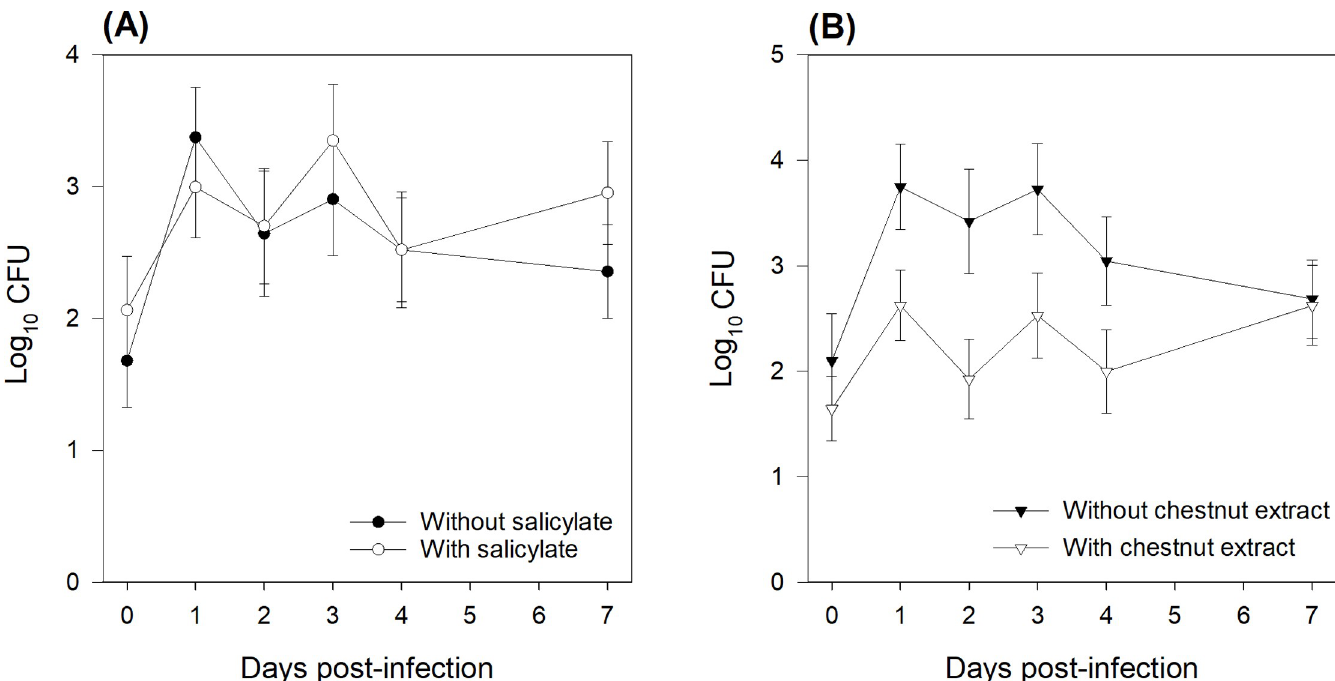
Fig 3. Effects of sodium salicylate supply (A) and chestnut extract supplementation (B) on Enterotoxigenic Escherichia coli F4 shedding as determined using plate counting in feces samples collected from all piglets at days 0, 1, 2, 3, 4 and 7 post-infection. Data are expressed as log 10 (Colony Formant Units). From days 0–4, pigs (N = 36) in the SA+ group were offered a daily dose of sodium salicylate (35 mg/kg BW per day, sodium salicylate, ReagentPlus 1 , S3007, Sigma-Aldrich Chemie GmbH; Buchs, Switzerland). From days 0–4, pigs (N = 36) in the SA- group were offered a daily dose of tap water. Pigs (N = 36) in the CE- group had ad libitum access to a control standard starter diet, which was formulated according to the Swiss feeding recommendations for pigs (Agroscope, 2017). Pigs (N = 36) in the CE+ group had ad libitum access to the chestnut extract (CE)-supplemented diet, in which wheat straw in the CE- diet was substituted for with 2% CE (Silvafeed Nutri P/ENC for Swine; Italy). P-values for the main effects: SA supply: P = 0.51; CE supplementation: P = 0.01; Time: P = 0.02.